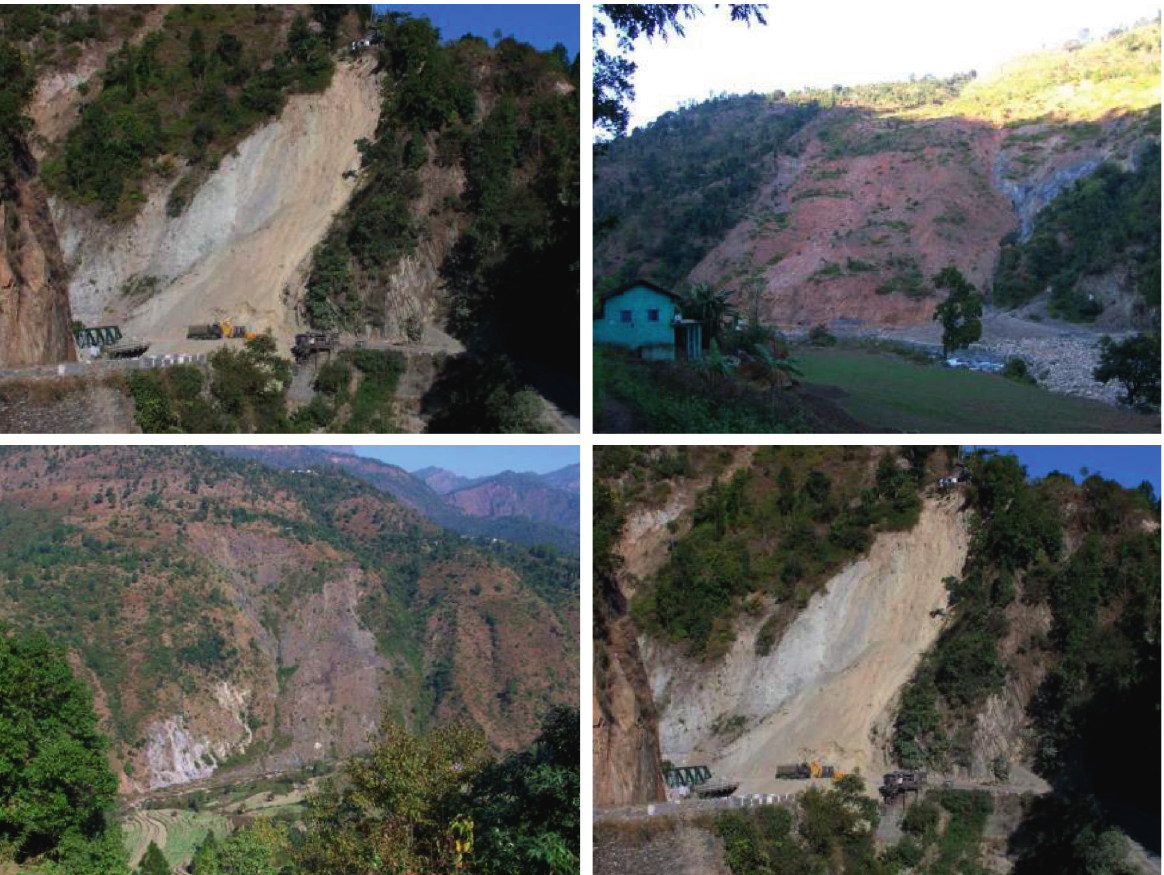
Figure 2: GSI Photographs of landslides in the study area (source: Geological Survey of India report: https://www.gsi.gov.in/webcenter/